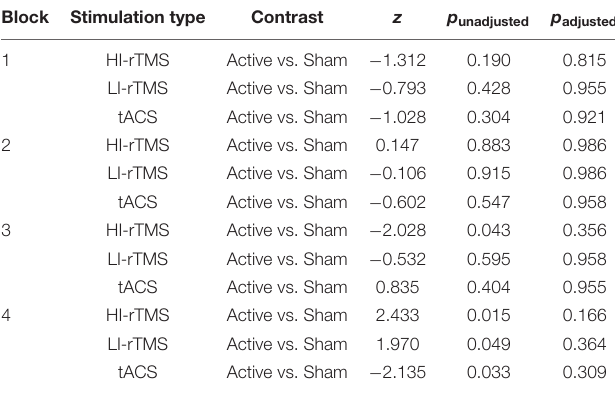
TABLE 2 | Simple effect comparisons for the Active vs. Sham Stimulation *Stimulation type *Block interaction for spatial bias. Block Stimulation